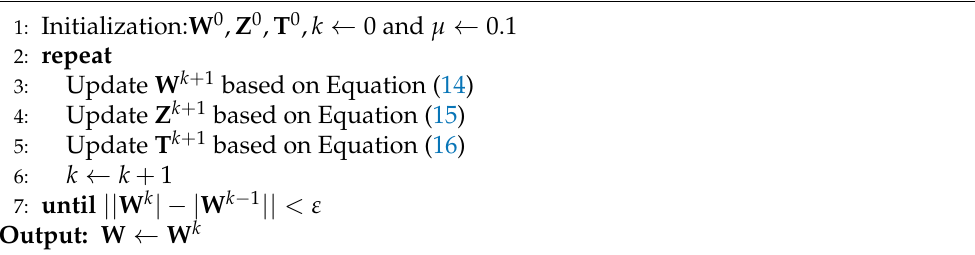
Algorithm 1 L1-norm penalization for spectral reflectance